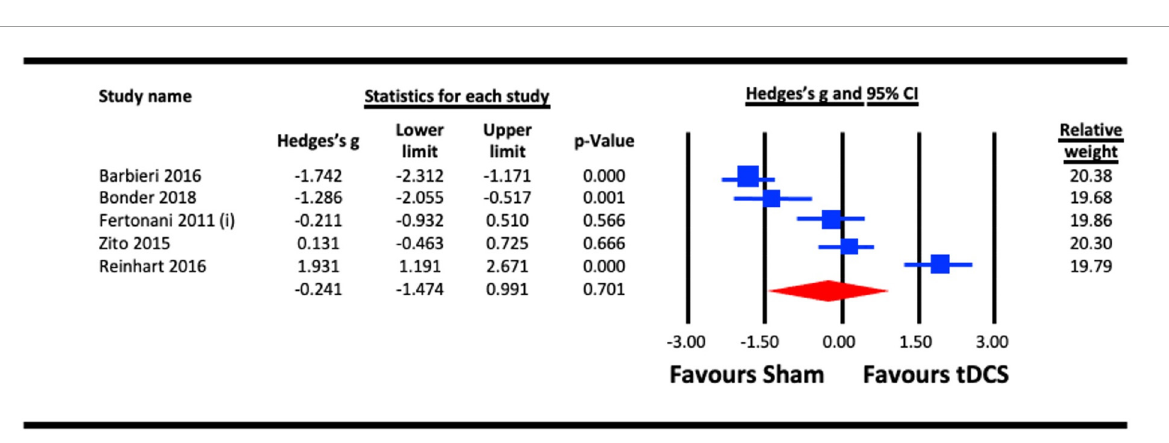
FIGURE11 Acute effect of anodal-transcranial direct current stimulation (a-tDCS) on reaction time. Barbieri (2016), combined effect of a-tDCS face and object tasks; Fertonani (2011) (i), effect of